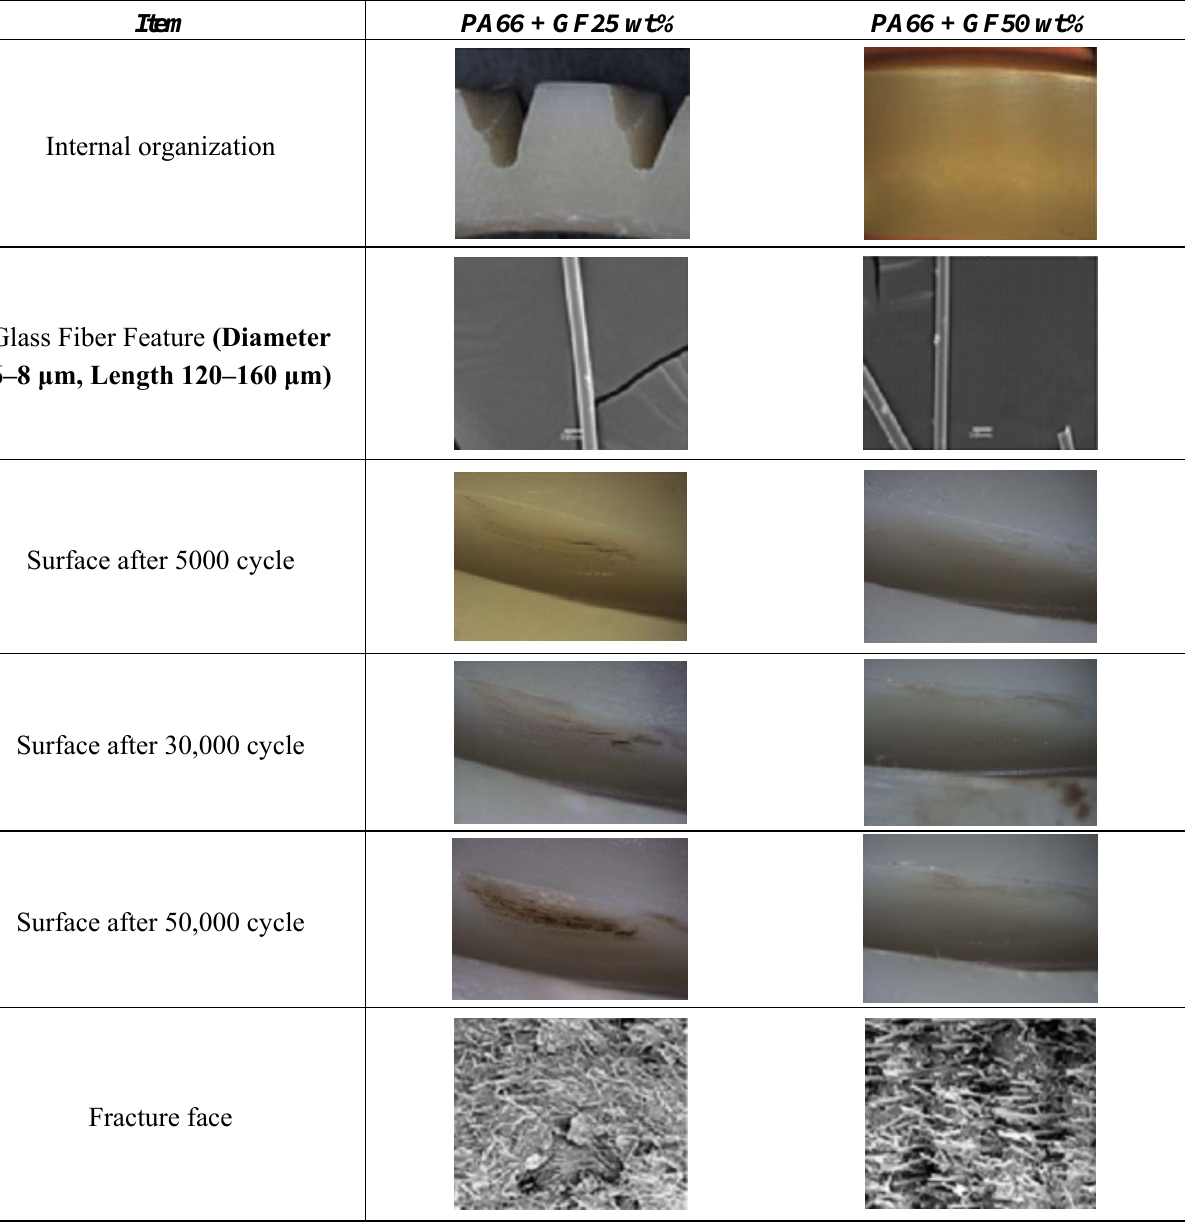
Table 10. Surface images of plastic worm wheel tooth part according to